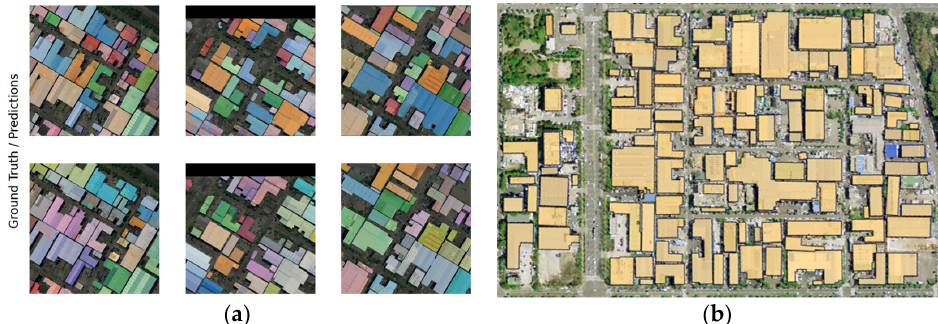
Figure 5. ( a ) The actual segmentation results plotted against the ground truth label, and ( b ) regular- ized building footprints overlaid on top of a sample area from validation dataset.